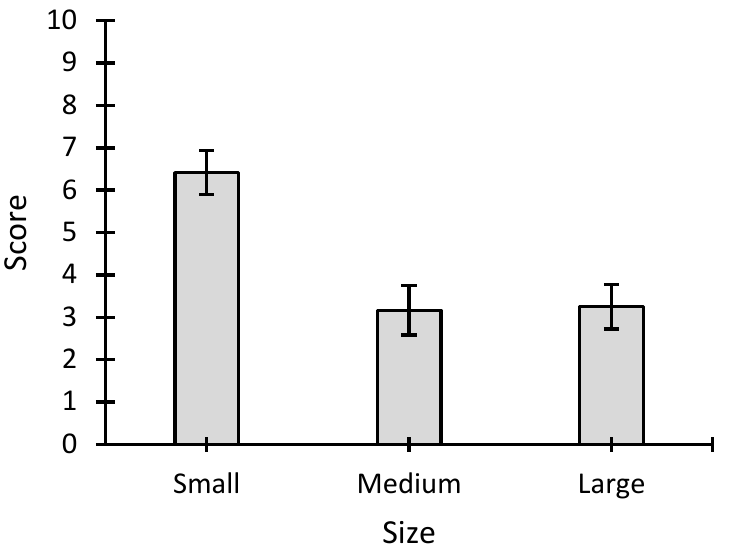
Figure 4. Score (mean ± standard error) for the item related to the subjective difficulty in performing the brain–computer interface task for each stimulus size (small, medium, and large).